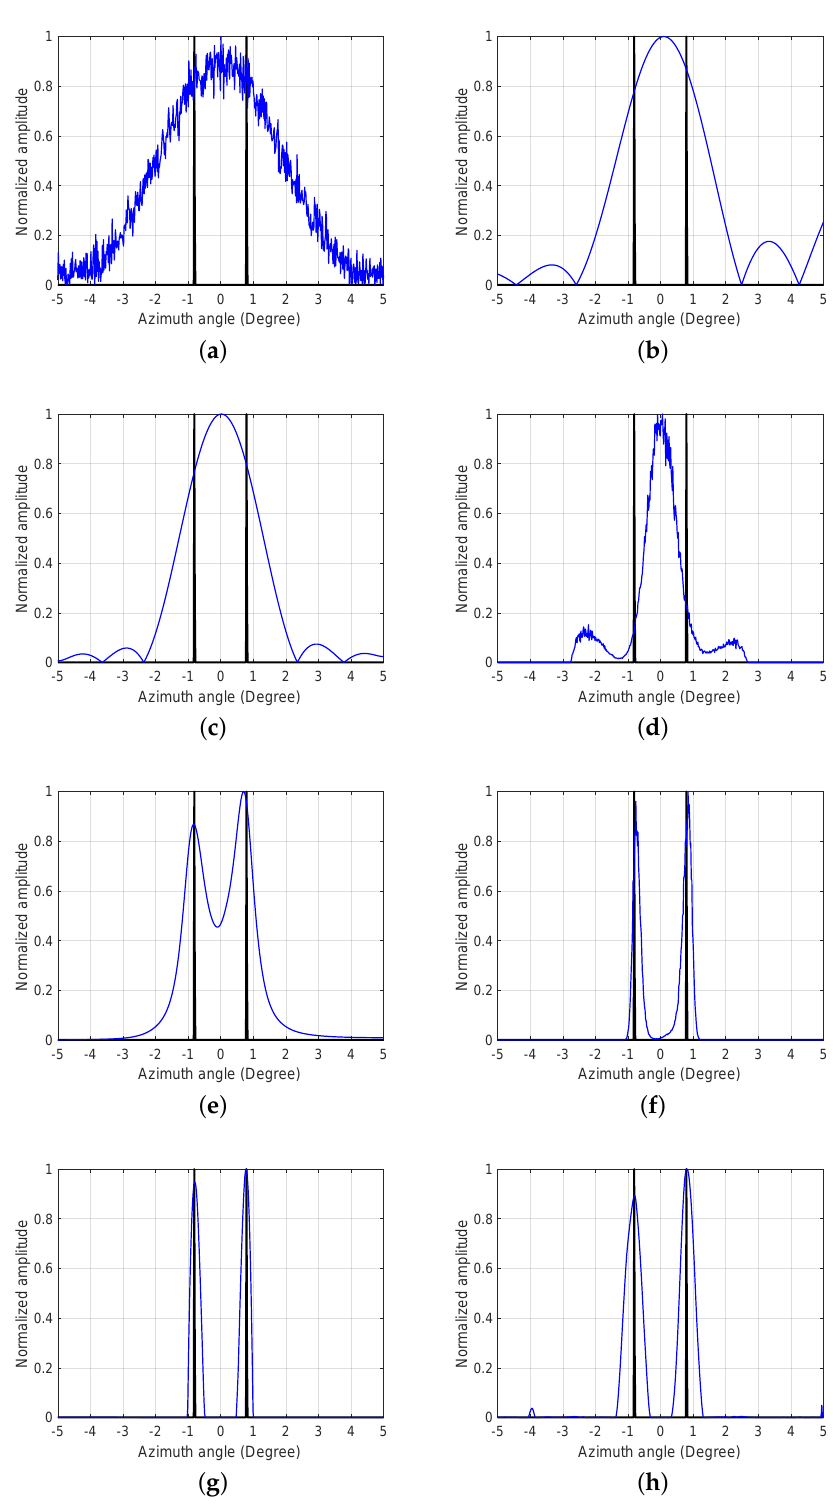
Figure 2. Point targets simulation results with the SNR of 20 dB. ( a ) Real-aperture echo. ( b ) Result processed by TSVDM. ( c ) Result processed by FTVM. ( d ) Result processed by MLE. ( e ) Result processed by IAA. ( f ) Result processed by MAPE. ( g ) Result processed by SSM. ( h ) Result processed by